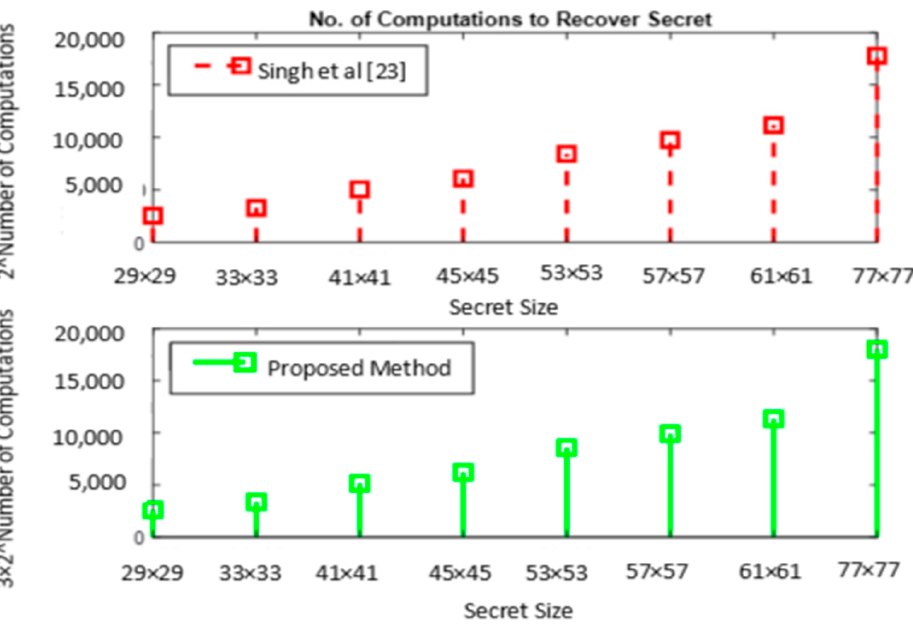
Figure 9. Brute-force attack—number of computations to recover secret.